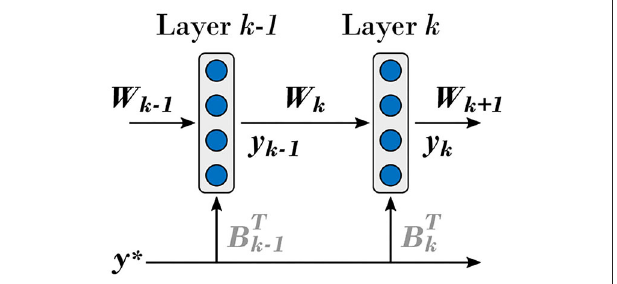
FIGURE 4 | Network of DRTP-updated linear hidden layers considered in the context of the mathematical proof of alignment between the DRTP and BP modulatory signals. The same conventions as in Figure 1 are